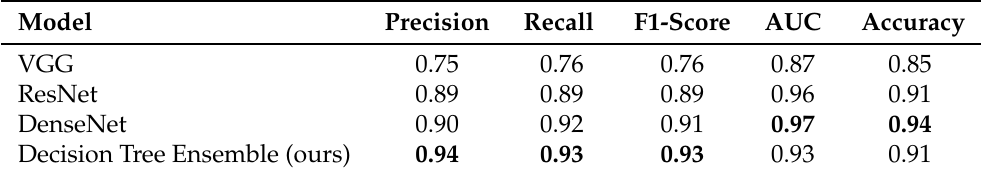
Table 2. Model comparison with convolutional architectures. Standard classification performance metrics measured on the test set. Our explainable model based on decision trees achieves high predictive performance that is comparable to existing black box convolutional neural network architectures.